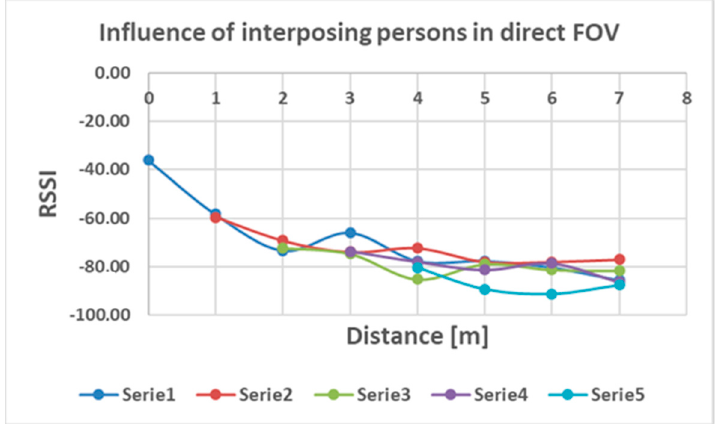
Figure 17. Readings of RSSI for variable number of persons sitting in direct communication line (Serie Figure17. 1—no persons (FOV), Serie 2—1 person, Serie 3—2 persons, Serie 4—3 persons, Serie 5—4 persons).